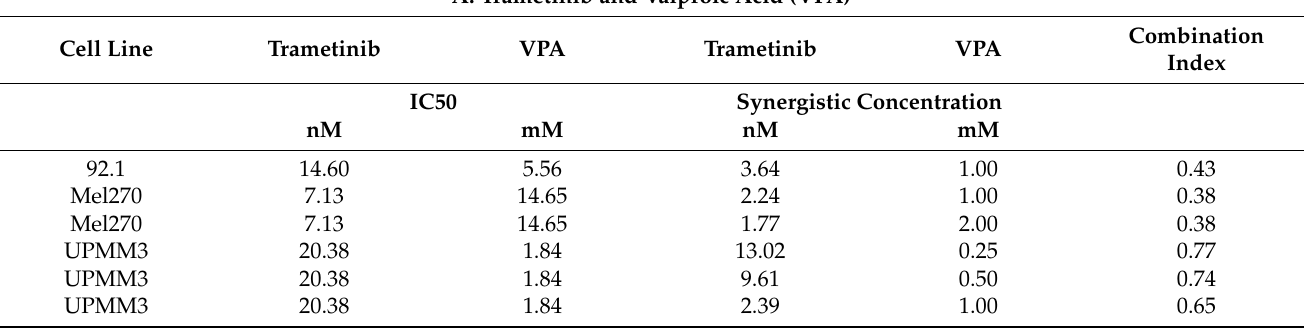
Table 3. Synergisms of trametinib with VPA (A), verteporfin (B) and cerivastatin (C) are shown. UM cell lines were treated for 72 h or seven days (*). The IC50 concentrations are reported as well as the minimum concentrations at which synergism was observed (synergistic concentration).